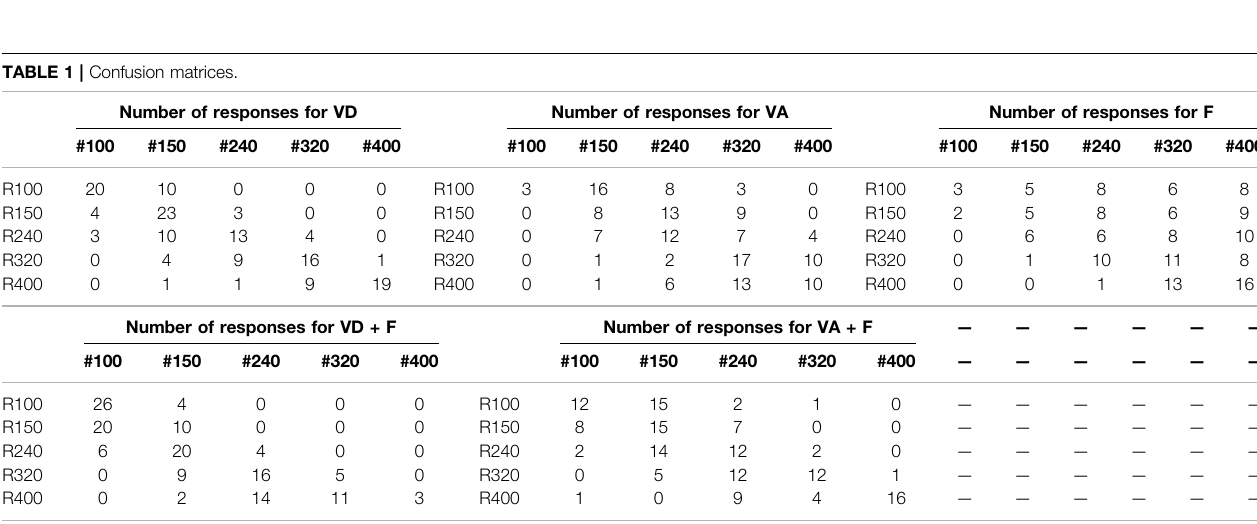
TABLE 1 | Confusion matrices. Number of responses for VD Number of responses for VA Number of responses for